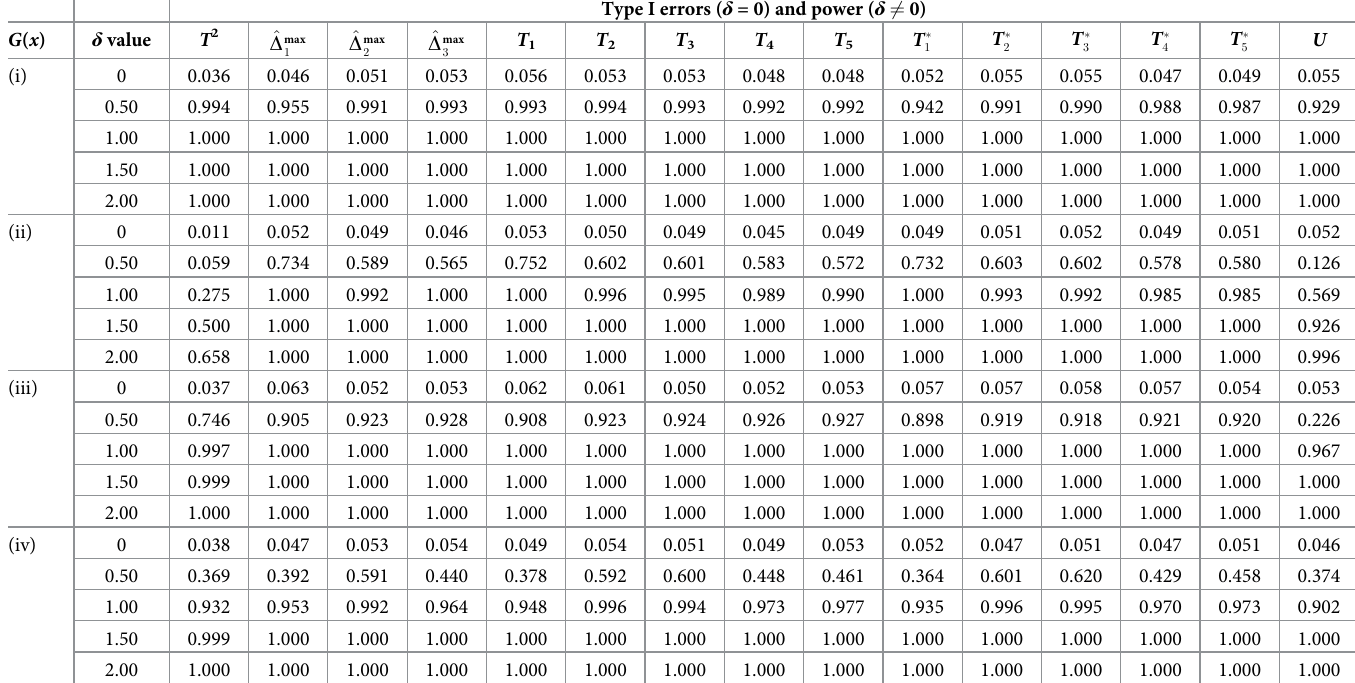
Table 6. Type I errors ( δ = 0) and power ( δ 6¼ 0) given by the investigated test statistics based on permutation approach in detecting location shift between two sam- ples generated from the four pairs of F ( x )and G ( x )with the non-independent variance-covariance matrix and sample sizes n = m =